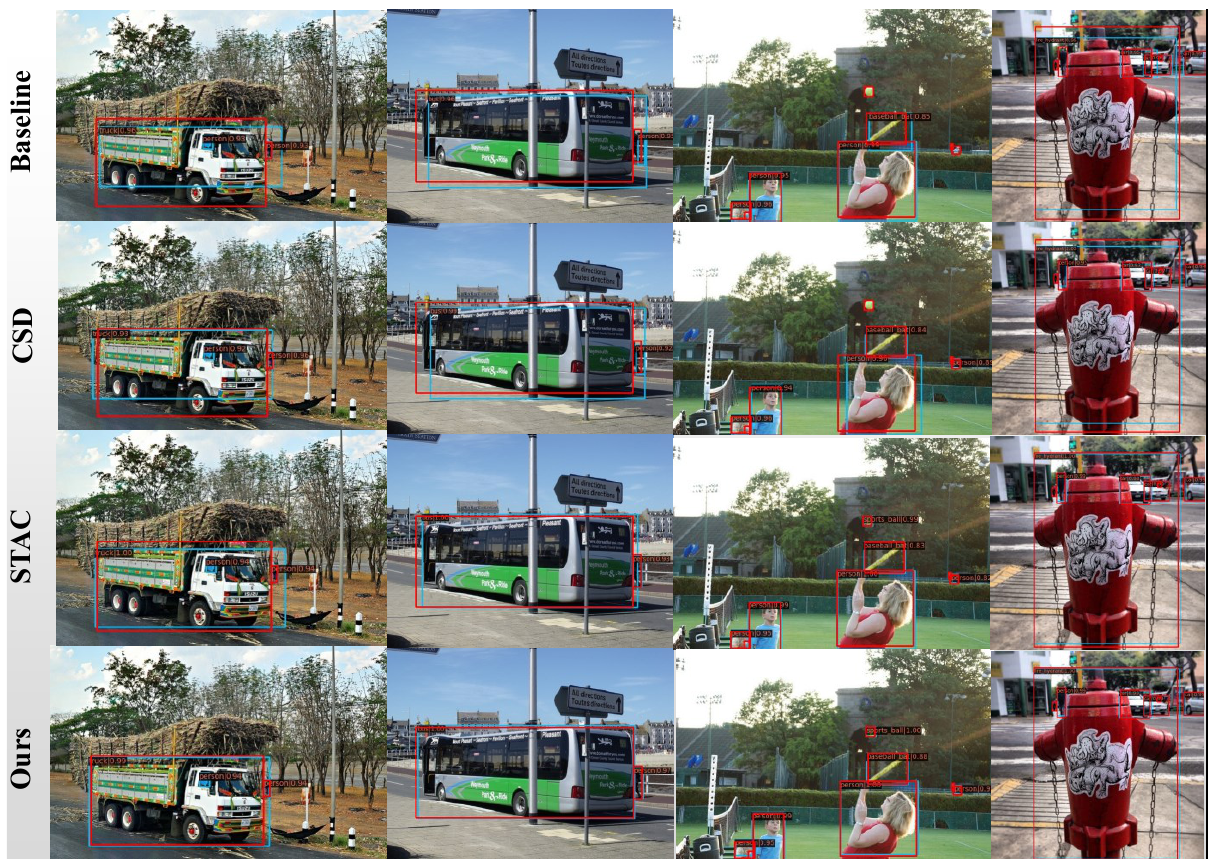
Figure 5. Visualization of prediction quality.